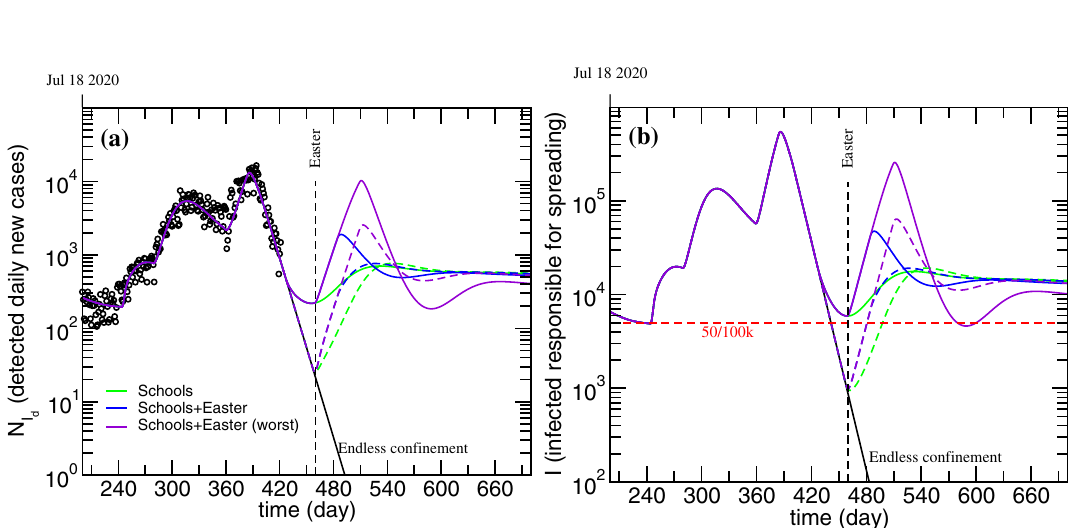
Figure 6. Evolution of the detected daily new cases ( a ) and infected non-isolated, responsible for spreading the disease ( b ). Impact of reopening schools on March 1 (solid lines) or April 1 (dashed lines) and the impact of doing so together with allowing Easter celebrations to different